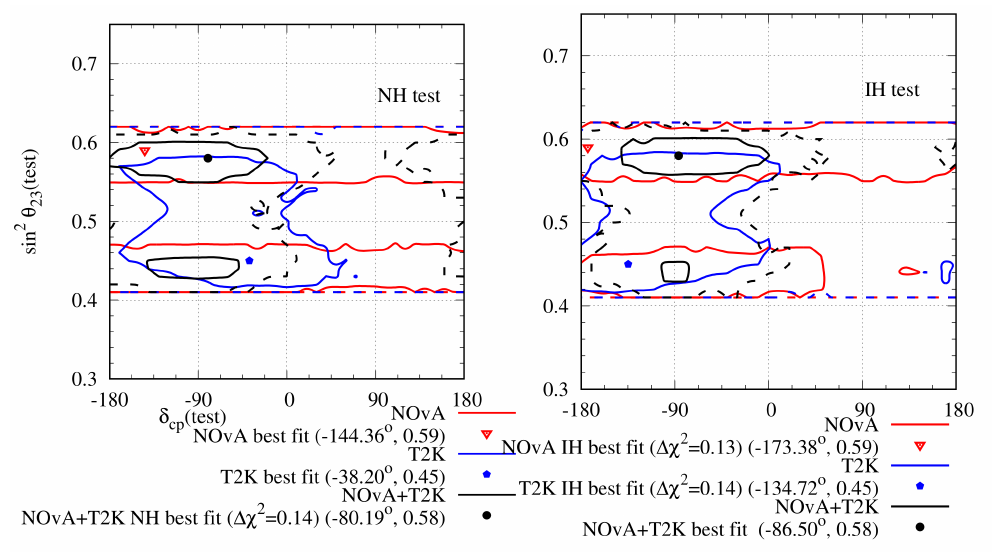
Figure 10. Allowed region in the sin 2 θ 23 − δ CP plane after analysing NO ν A and T2K complete data set with LIV hypothesis. The left ( right ) panel represents test hierarchy to be NH (IH). The red (blue) lines indicate the results for NO ν A (T2K) and the black line indicates the combined analysis of both. The solid (dashed) lines indicate the 1 σ (3 σ )-allowed regions. The minimum χ 2 for NO ν A (T2K) with 50 (88) bins is 47.71 (93.14) and it occurs at NH. For the combined analysis, the minimum χ 2 with 138 bins is 145.09.